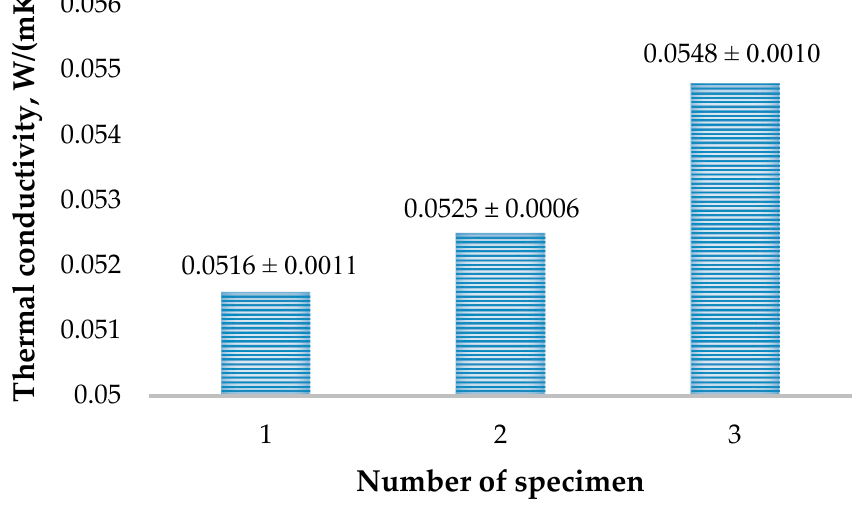
Figure 6. Thermal conductivity studies of wood waste, when fraction, mm: 1—0/20; 2—0/10 and 3— 0/5.